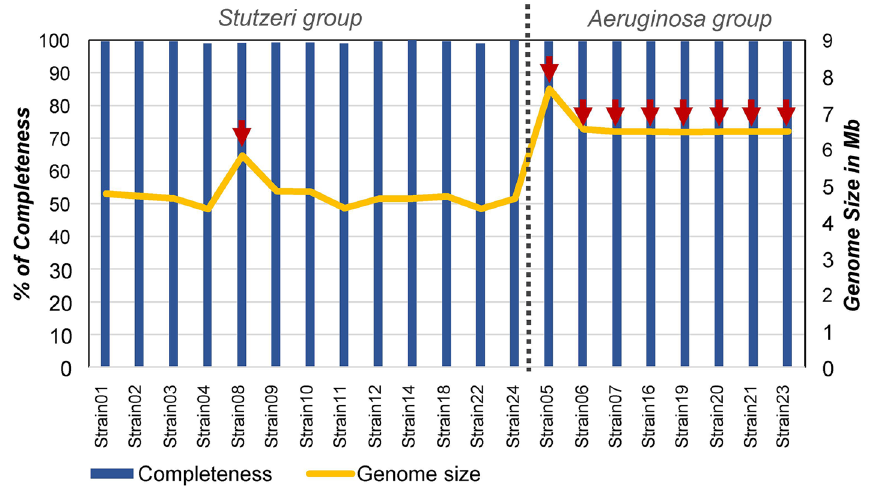
Figure 2. Statistics of whole genome sequencing analysis. Bars represent percentages of completeness per strain from CheckM analysis, while the line represents the genome size in Mb. Red arrows indicate the strains of high tolerance to acidity, antibiotics and heavy